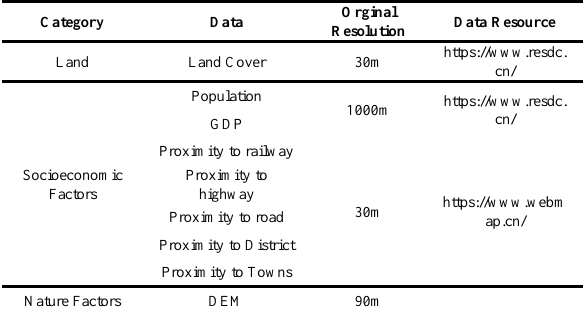
Table 1. The spatial driving factors of the land use change in this